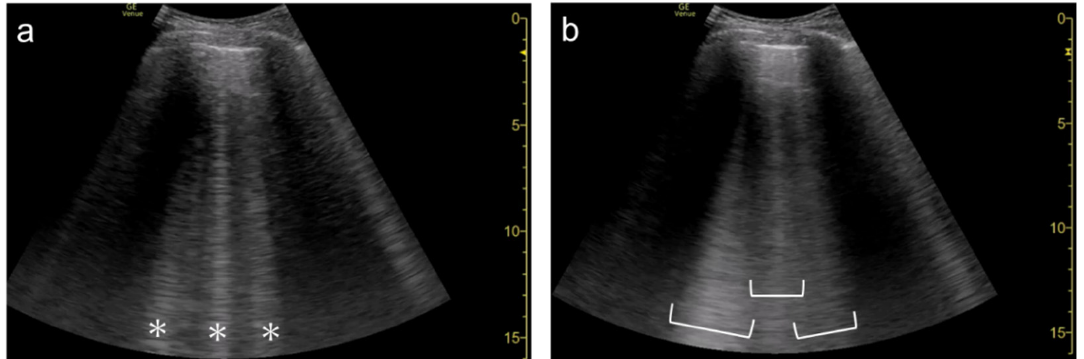
Figure 4. Ultrasound images obtained by LOGIQ V scanner (GE Healthcare) with a linear transducer without ( a ) and with spatial compound imaging ( b ) in cardiogenic pulmonary edema. With spatial compound imaging enabled, each single B-line (asterisks) changes to multiple lines (dots) radiating from the same point on the pleural line.